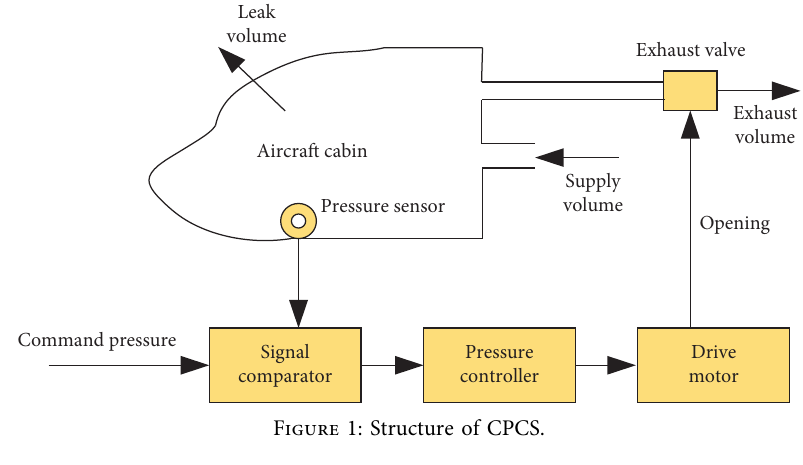
Figure 1: Structure of